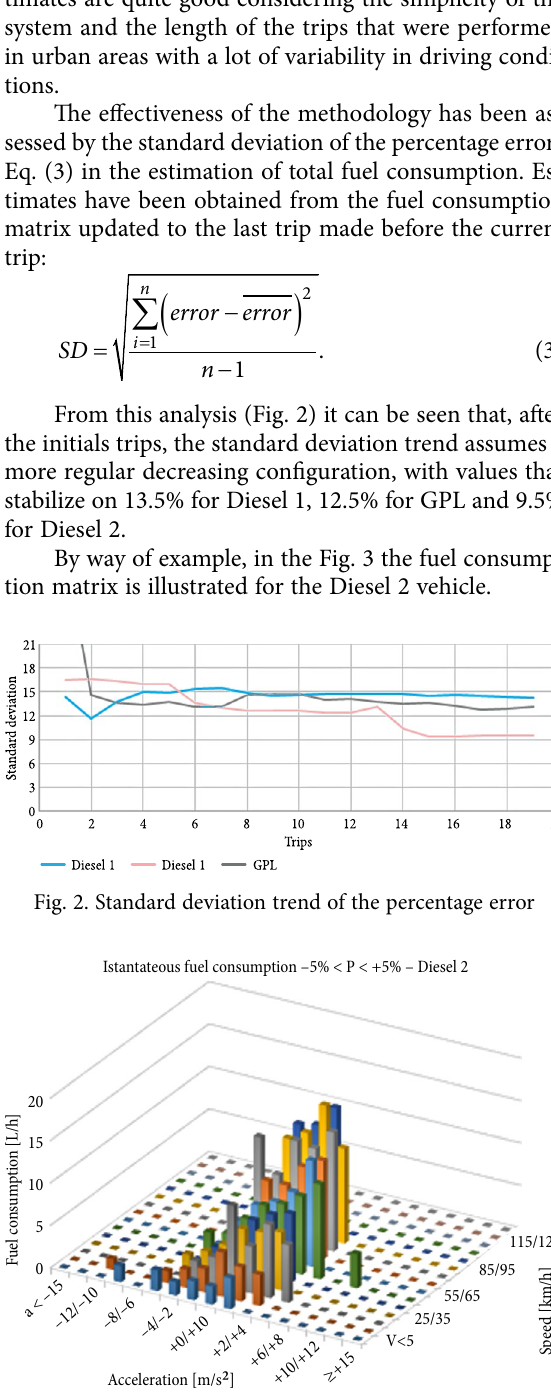
Fig. 3. Fuel consumption matrix for Diesel 2